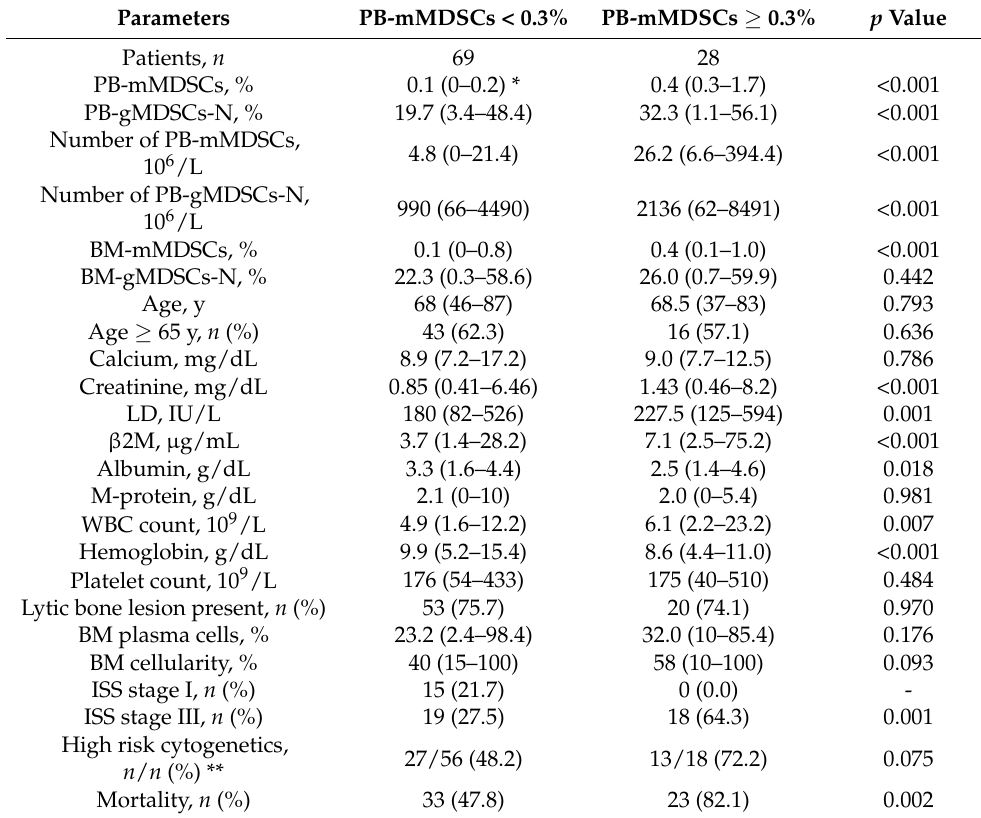
Table 3. Comparison of laboratory and clinical findings of two groups divided by the level of monocytic myeloid-derived suppressor cells of peripheral blood in 97 patients newly diagnosed with plasma cell